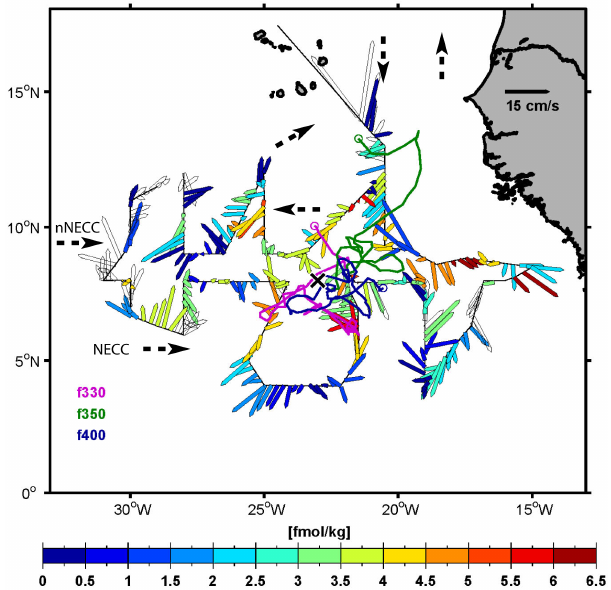
Figure 11. Horizontal distribution of ADCP velocity vectors con- verted to the isopycnal σ θ = 26.88kgm − 3 recorded in October– November 2010 with current vectors interpolated on 0.25 ◦ inter- vals colored with the maximum tracer (CF 3 SF 5 ) concentration (in fmolkg − 1 ) of the nearest CTD bottle measurements near this isopy- cnal. Colored dots show the maximum tracer at all tracer measure- ment locations even if no ADCP measurements are available. The black × with a white frame at ∼ 8 ◦ N, 23 ◦ W shows the deploy- ment location where the tracer and the three floats were deployed in April 2008. The three float tracks for the period April 2008 to November 2010 are included as red, green and blue curves with a circle for the November 2010 location. Float f330 is shown through the transmission end on 16 December 2009 at 10.04 ◦ N, 23.12 ◦ W as a red curve. The main current field is indicated by dashed black arrows. Please note that the tracer color scale is different to the color scale in Fig.